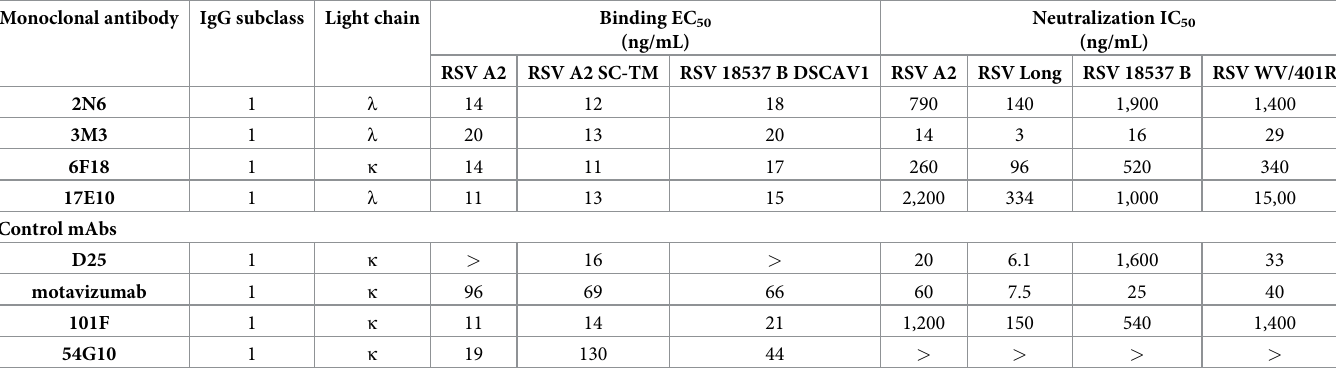
Table 1. Binding and neutralization values for isolated RSV F-specific mAbs. Monoclonal antibody IgG subclass Light